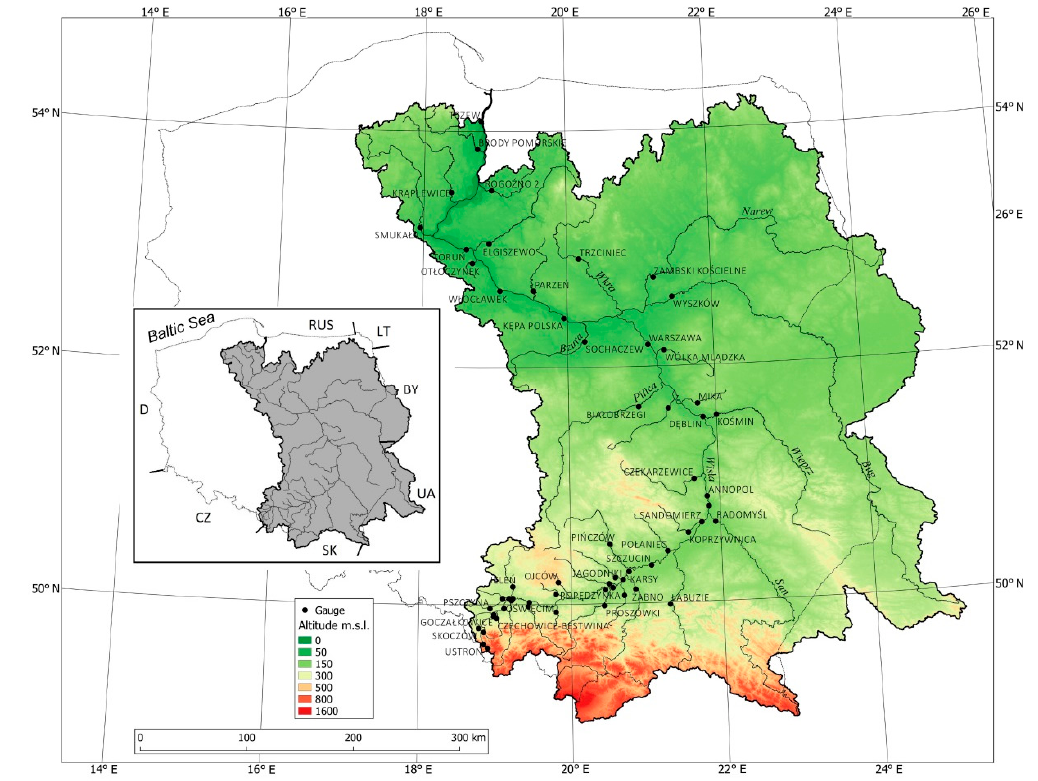
Figure 1. Geographical position of the Vistula River basin in Poland.